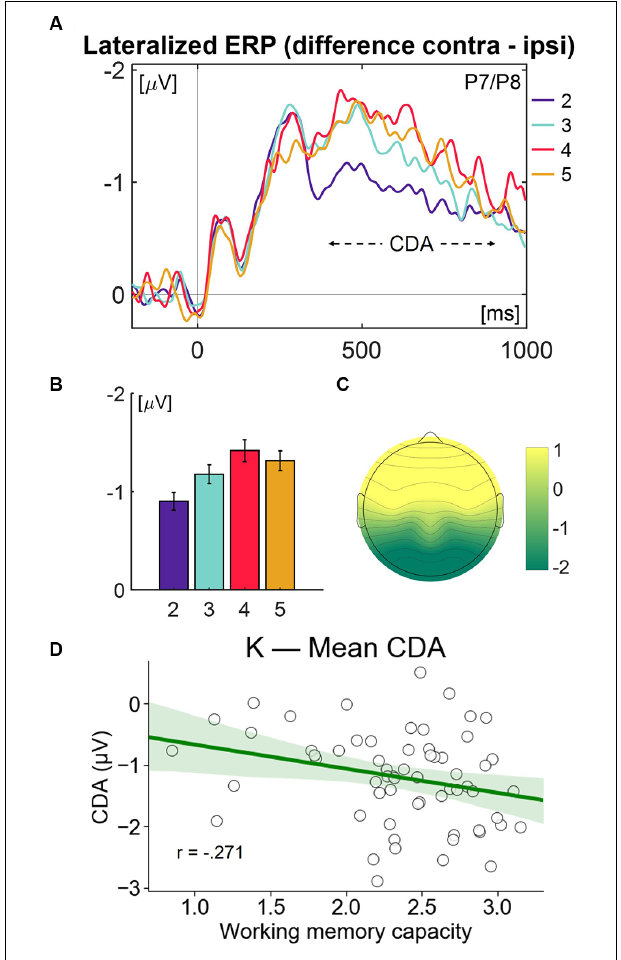
FIGURE 4 | (A) Grand average lateralized waveforms (contra—ipsi), averaged across P7/P8 electrodes, separately for all lateralized target distributions. For statistical analyses of CDA, the mean amplitude from 400 to 900 ms was used. (B) Mean CDA amplitude from 400 to 900 ms, separately for each load. Error bars denote standard errors of the mean, corrected with within-subjects comparisons. (C) Topography of the average activity at each electrode site from 400 to 900 ms. As values were averaged across paired electrodes, the topography is perfectly symmetrical. (D) Scatterplot of working memory capacity (K) averaged across loads and contralateral delay activity (CDA) averaged across loads.